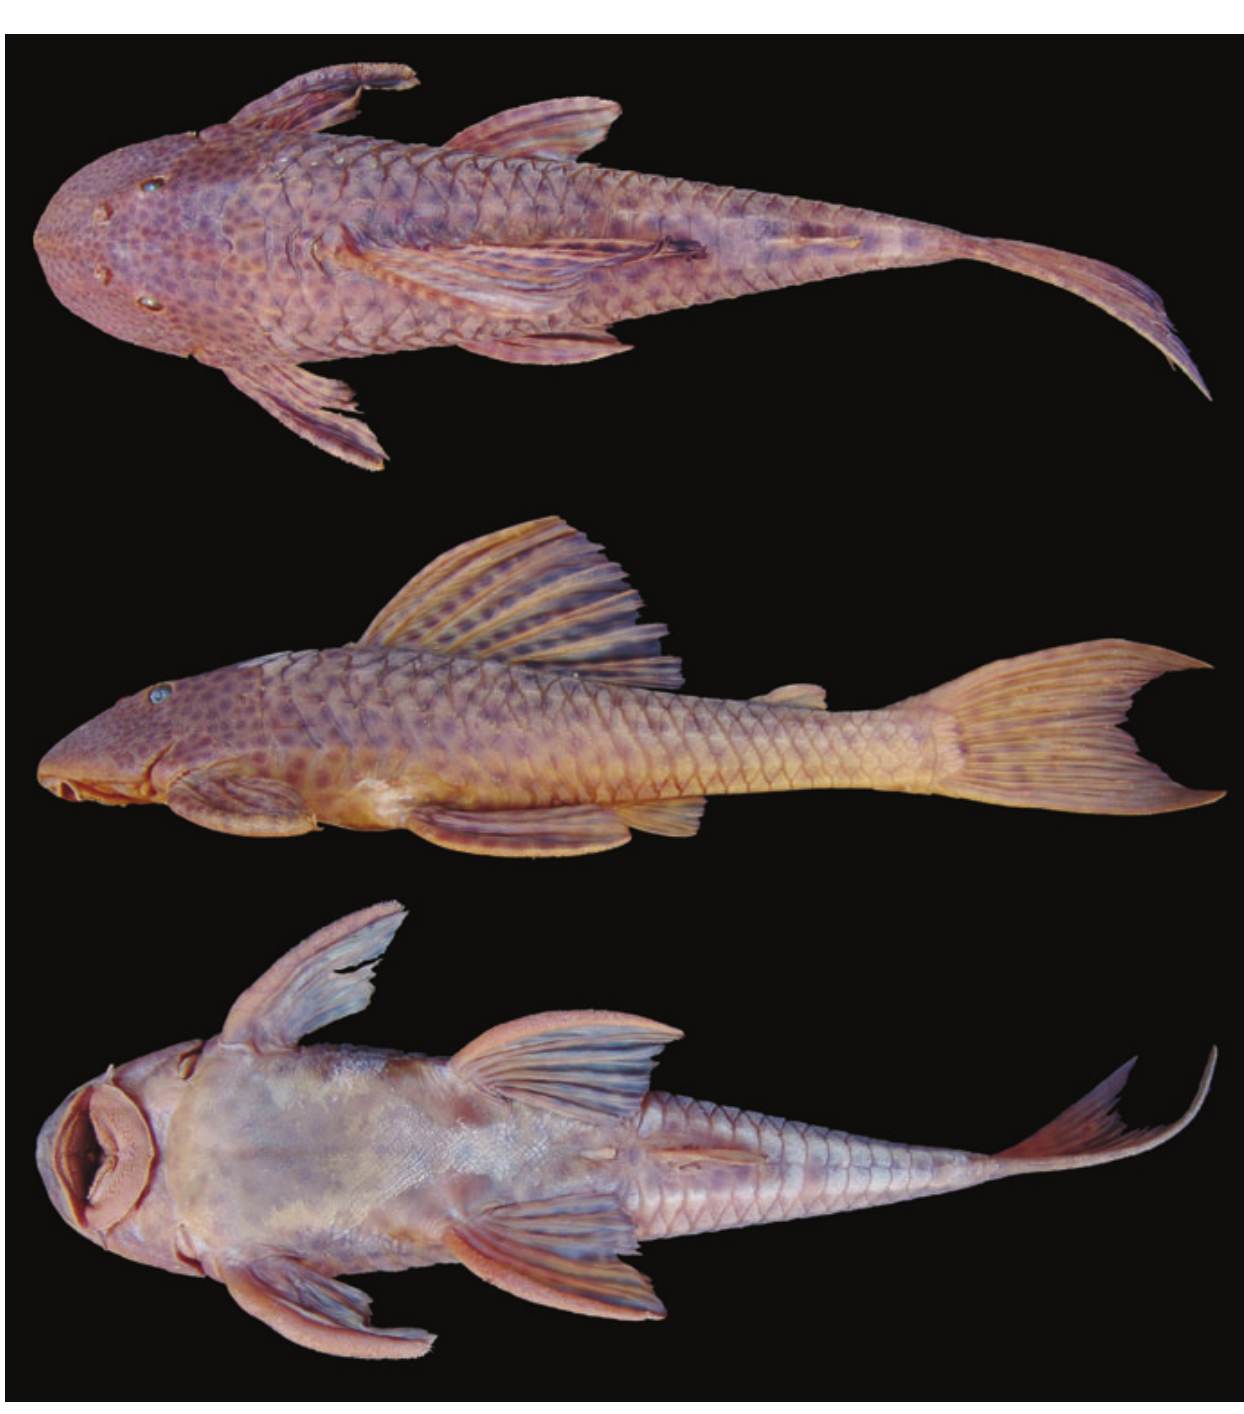
Fig. 4. Hypostomus derbyi , NUP 677, 230.6 mm SL, Salto Caxias reservoir, rio Iguaçu, Municipality of Capitão de Leônidas Marques/Nova Prata do Iguaçu, Paraná,